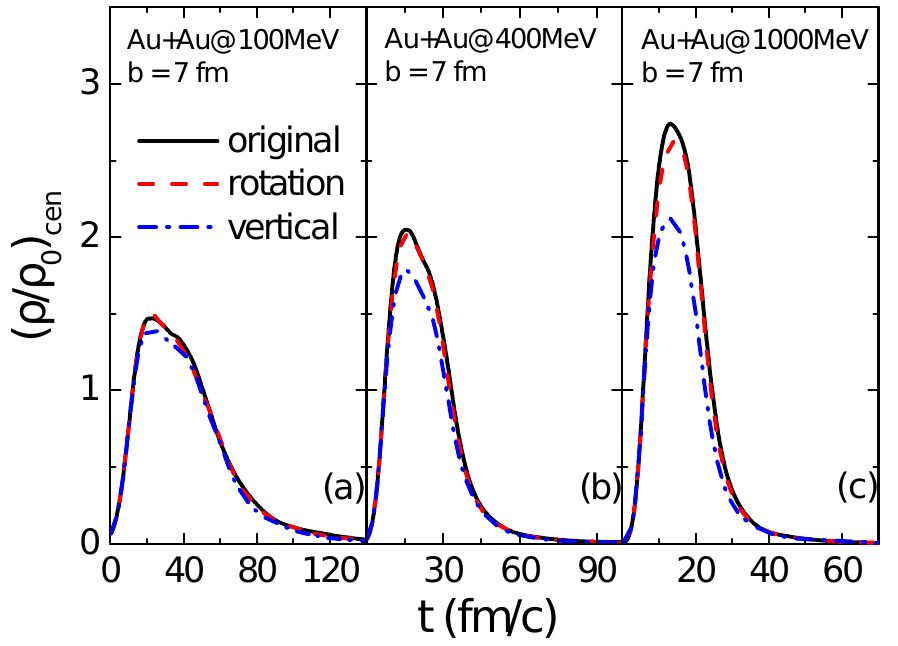
Figure 5. Time evolution of the central density from three collision prescriptions in non-central Au+Au collisions at E lab = 100 ( a ); 400 ( b ); and 1000 ( c ) AMeV.